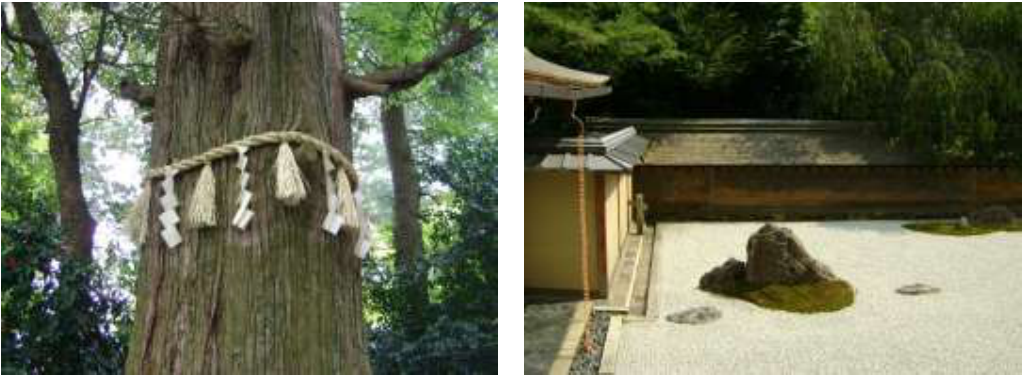
Figure 1. Shimenawa rope around a spirit inhabited tree in Ise. Ryōan-ji zen garden in